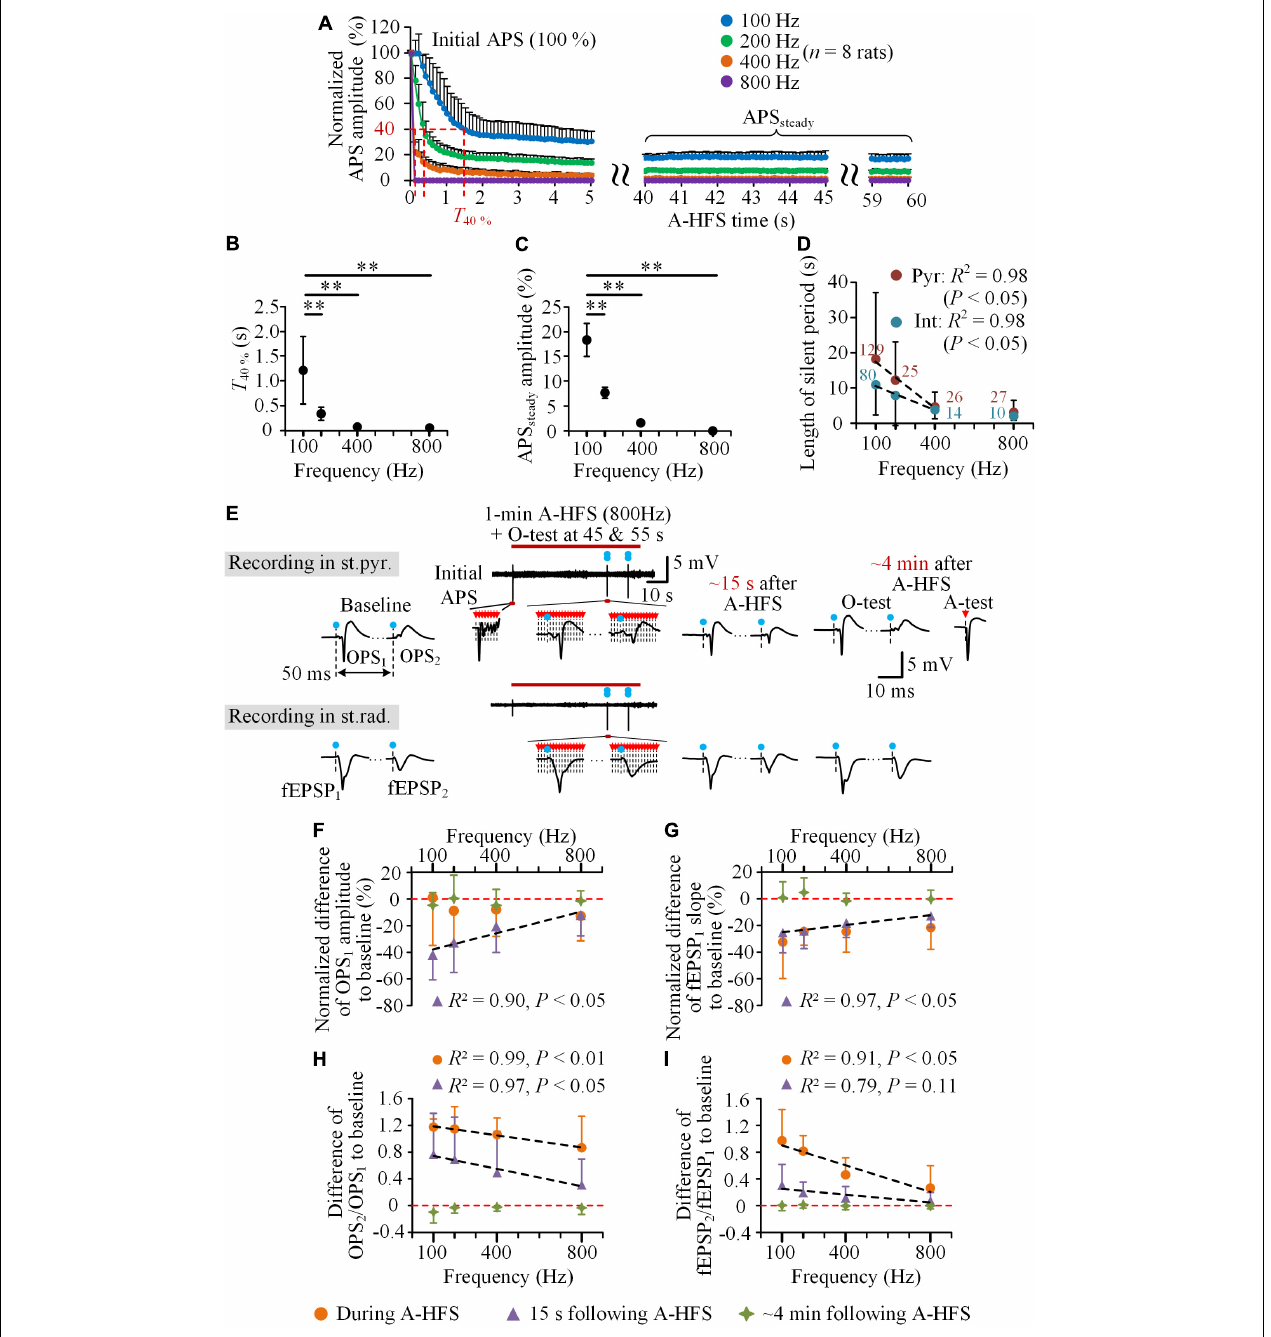
FIGURE 4 | Neuronal responses to the trains of A-HFS with different pulse frequencies. (A) The mean normalized APS amplitudes evoked by each pulse during 1-min A-HFS with 100, 200, 400, and 800 Hz. Except the amplitude of the first APS being 100%, the other data were the average amplitude of APSs evoked by 10 successive pulses at every 0.1 s. (B,C) Changes of the time for the APS amplitude dropping to 40% ( T 40% ) (B) and the average amplitude of APSs in the late 40–60 s period of A-HFS (APS steady ) (C) with the A-HFS frequencies. ∗∗ P < 0.01, one-way ANOVA with post hoc Bonferroni tests, n = 8 rats. (D) Changes of the lengths of silent period following the A-HFS with different frequencies for the two types of neurons (Pyr & Int). The digits are the number of individual neurons from 48 rats (100 Hz) and eight rats (200, 400, and 800 Hz). (E) Typical examples of the OPSs in the st.pyr. and fEPSPs in the st.rad. evoked by the O-test paired pulses before, during, and after 1-min 800 Hz A-HFS. The blue dots with dashed lines denote the artifacts of O-tests and the red arrows with dashed lines denote the artifacts of A-HFS pulses and A-test pulse. (F–I) Comparisons of normalized difference of OPS 1 amplitude (F) , normalized difference of fEPSP 1 slope (G) , difference of OPS 2 /OPS 1 (H) , and difference of fEPSP 2 /fEPSP 1 (I) to baseline during A-HFS, at 15 s following and at ∼ 4 min after the end of A-HFS with different frequencies ( n = 8 rats). Negative values mean decreases and positive values mean increases from baselines denoted by the red dashed lines. The black dashed lines in (D) and (F–I) denote Pearson linear correlations between the abscissa and ordinate values with the results of R 2 and P shown on the upside or downside.